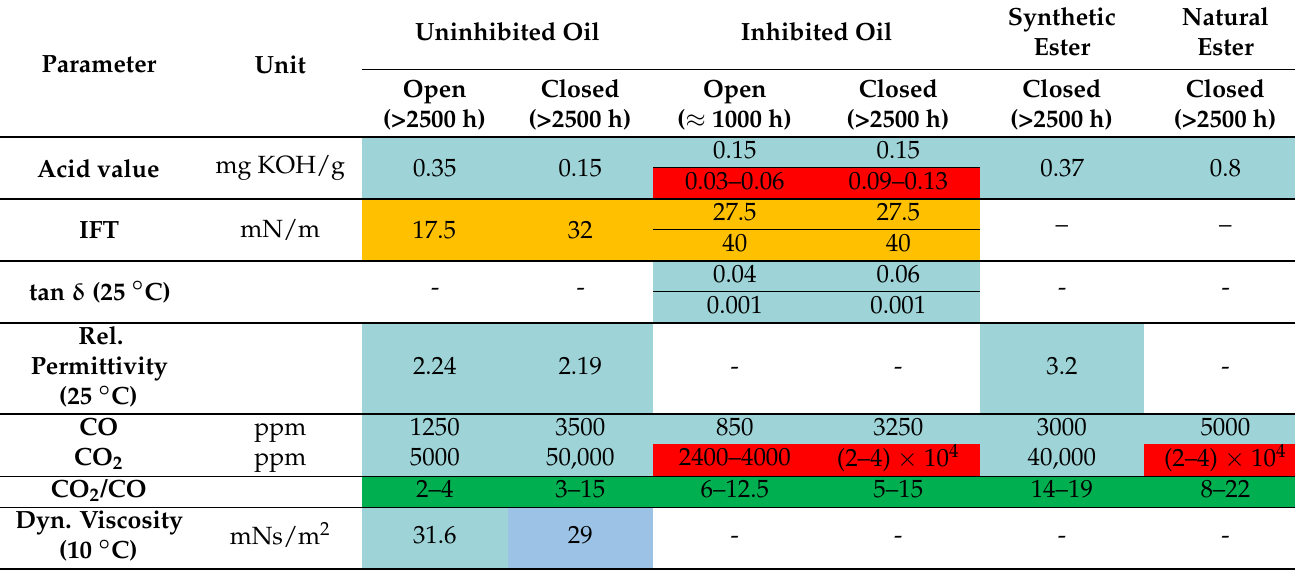
Table 5. Definition of threshold values for different transformers and liquids for 350 DP (In case of two threshold values per parameter, the upper value stands for Oil B and the lower for Oil